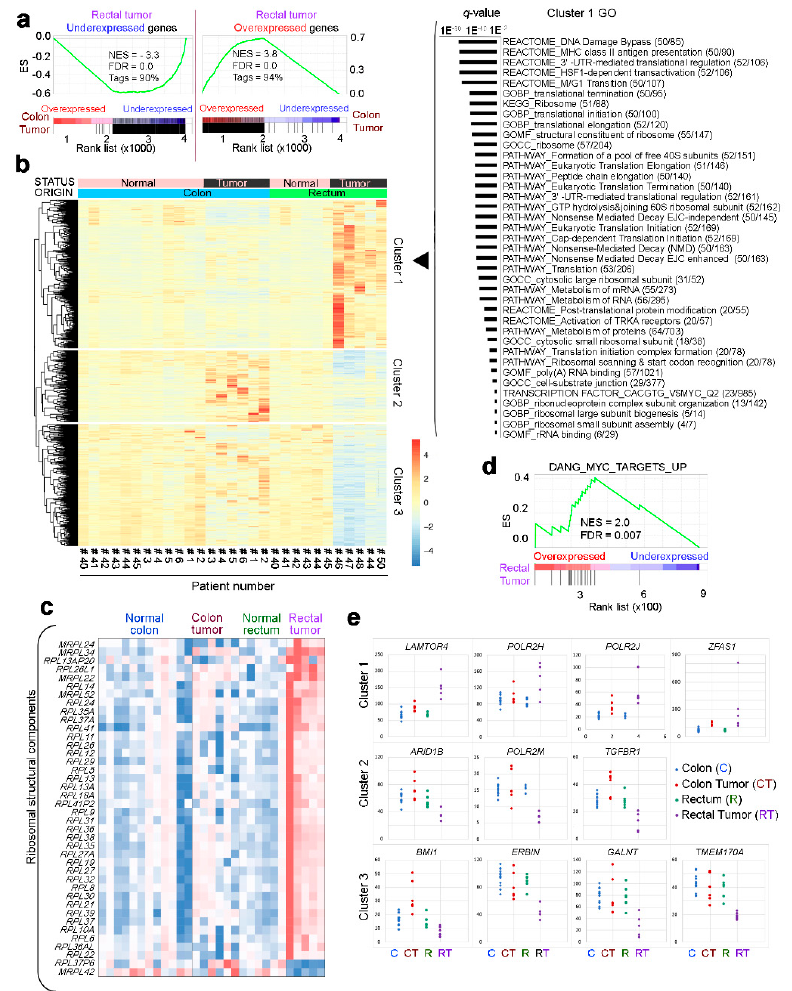
Figure 3. Transcriptomic comparison of colon and rectal tumor organoids. ( a ) Gene Set Enrichment Analysis (GSEA) comparing the genes dysregulated in colon and rectal tumor organoids. ( b ) Heatmap showing the genes that behave distinctly during tumor progression in the two locations (FDR 5%). Clusters 1–3 group genes whose expression changes distinctly in colon and rectal tumors. The list to the right shows Gene Ontology analysis of Cluster 1 genes (only induced in rectal tumors)